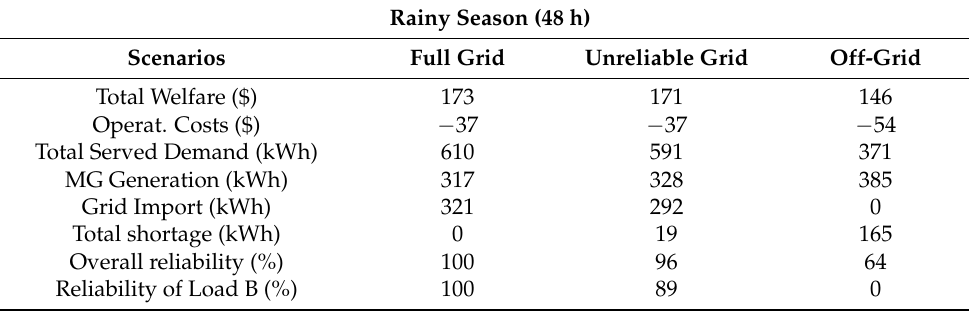
Table 2. Result Summary Table for Scenarios in the Rainy